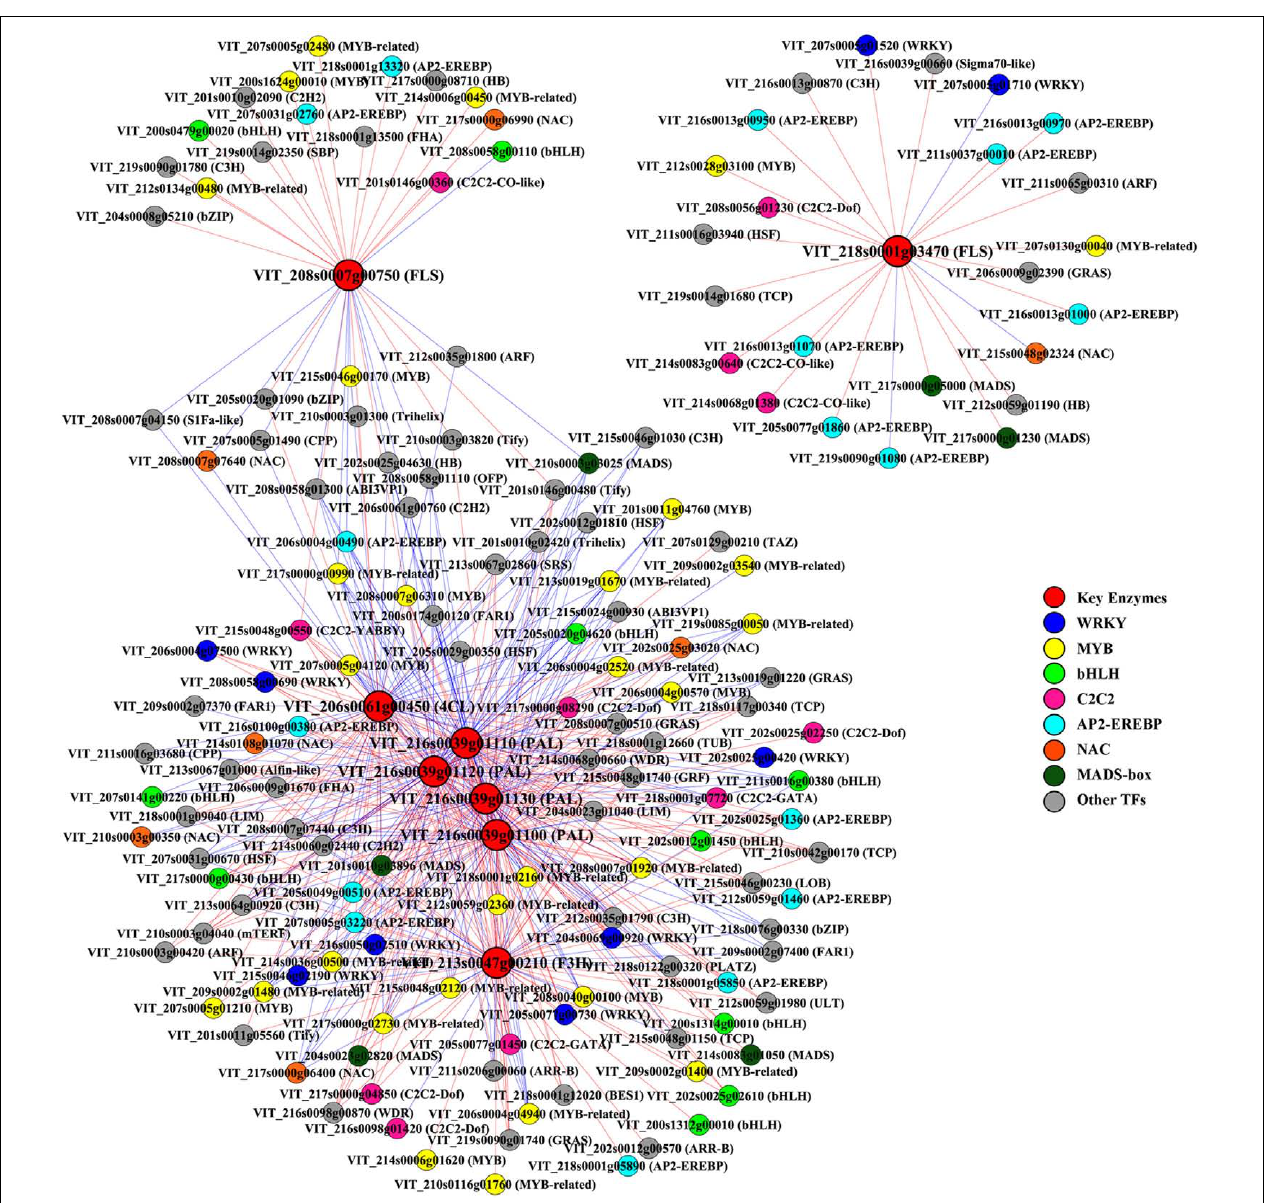
FIGURE 5 | Co-expression analysis of key enzymes required for phenolic biosynthesis and transcription factors (TFs) in berries from different cluster sunlight exposed grapes during development. Key enzymes are assigned in rectangle and TFs in ellipse . PAL, phenylalanine ammonia-lyase; 4CL, 4-coumarate: CoA ligase; F3H, flavanone 3-hydroxylase; FLS, flavonol synthase. Positive and negative correlations are provided by red arrows and blue inhibitory arrows,